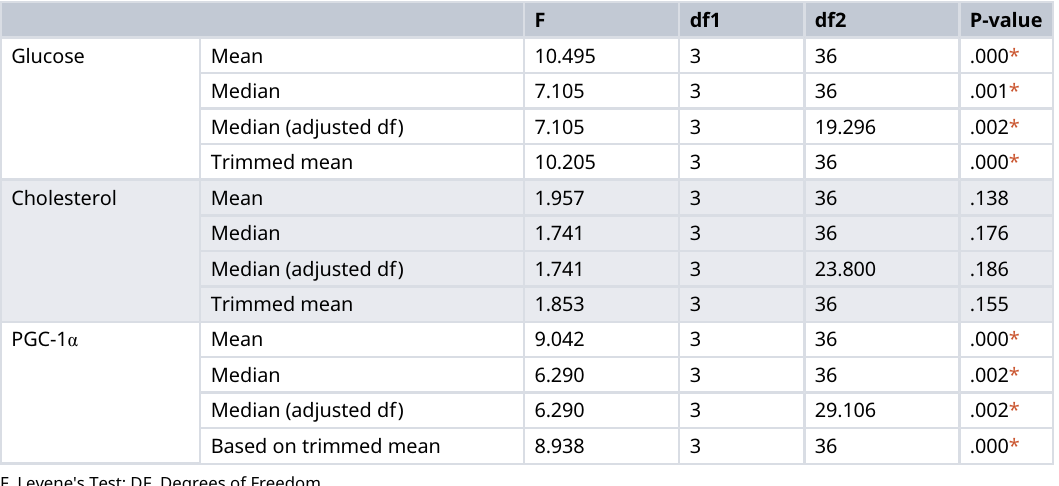
Table 1. Statistical interpretations based on homogeneity